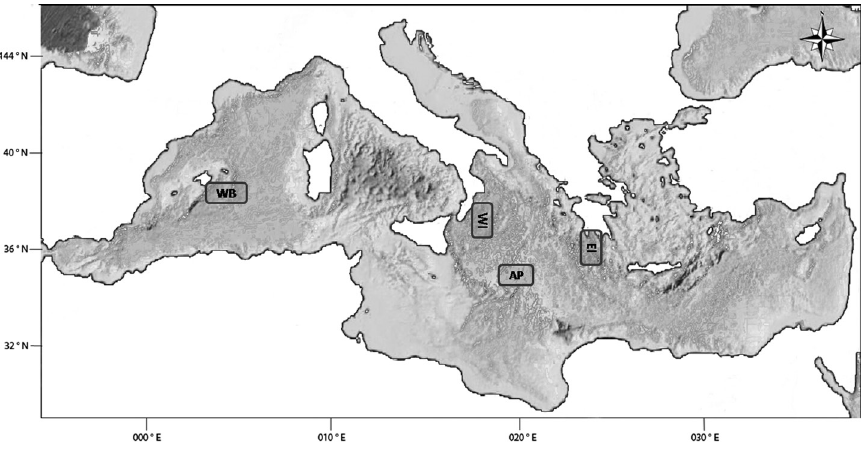
Fig . 1. – Map of Mediterranean Sea, including the sampled areas: western Balearic (WB), western Ionian (WI), eastern Ionian (EI) and the central abyssal plain